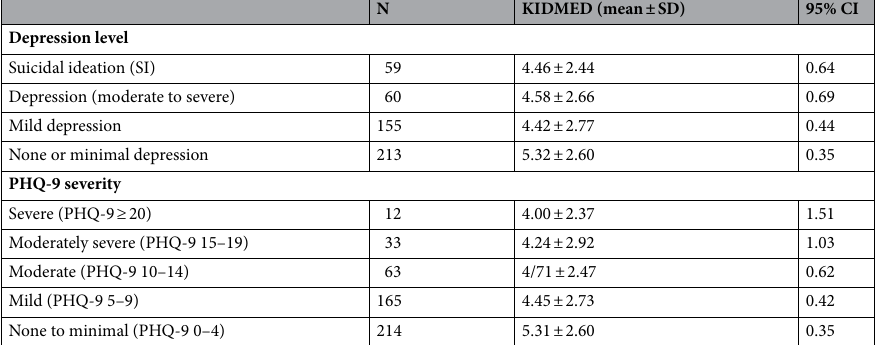
Total KIDMED scores did not differ significantly between individuals with or without SI, nor across tra- ditional PHQ-9 severity levels, excepting a higher score in those with “no” depression ( x = 5.3 ± 2.6, ˜ x = 5.0) compared to those with “mild” ( x = 4.4 ± 2.7, ˜ x = 4.0, p < 0.001).